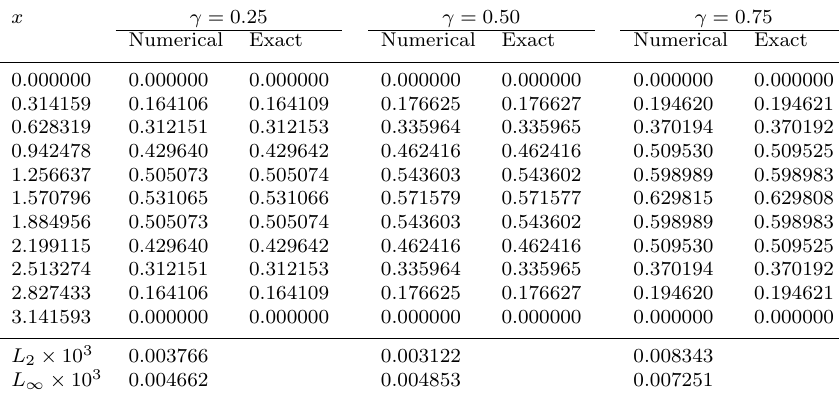
Table 1. The comparison of solutions and error norms of the diffusion problem for M = 40, ∆t = 0 . 00007 and t f = 0 . 35. x γ = 0 . 25 γ = 0 . 50 γ = 0 . 75 Numerical Exact Numerical Exact Numerical Exact 0.000000 0.000000